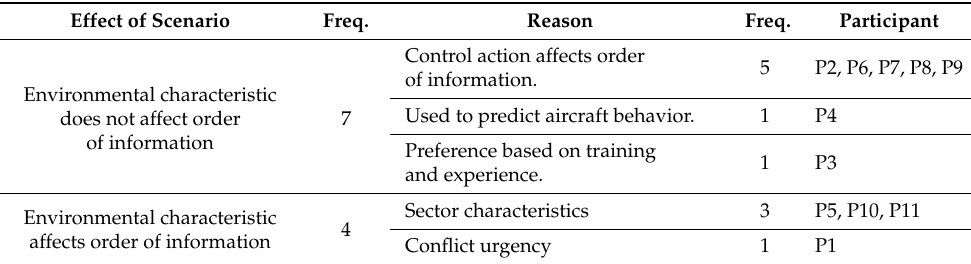
Table 6. Effects of scenario characteristics in the order of information processed.